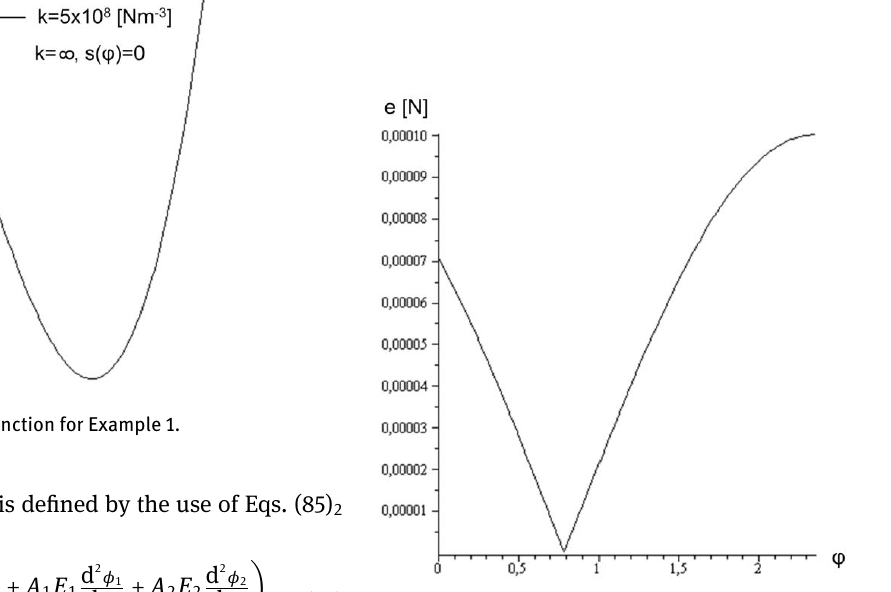
Figure 11: The plots of M 1 = M 1 ( φ ) and M 2 = M 2 ( φ ) for Example 1.